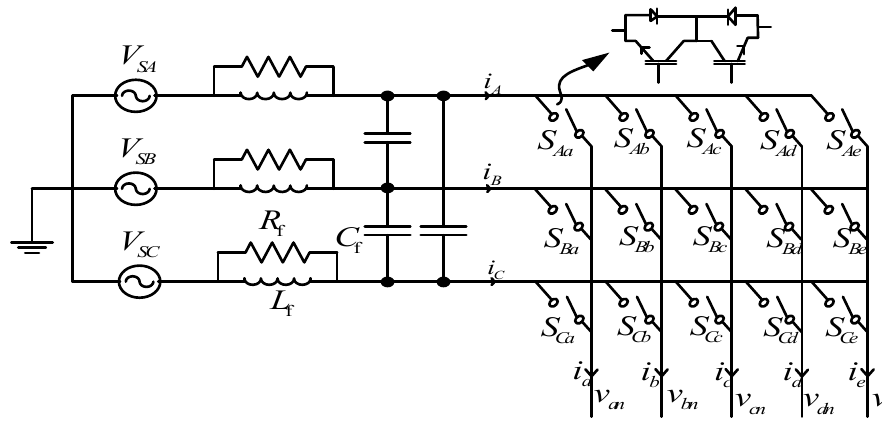
Figure 3. Diagram of a three-phase to five-phase matrix converter.